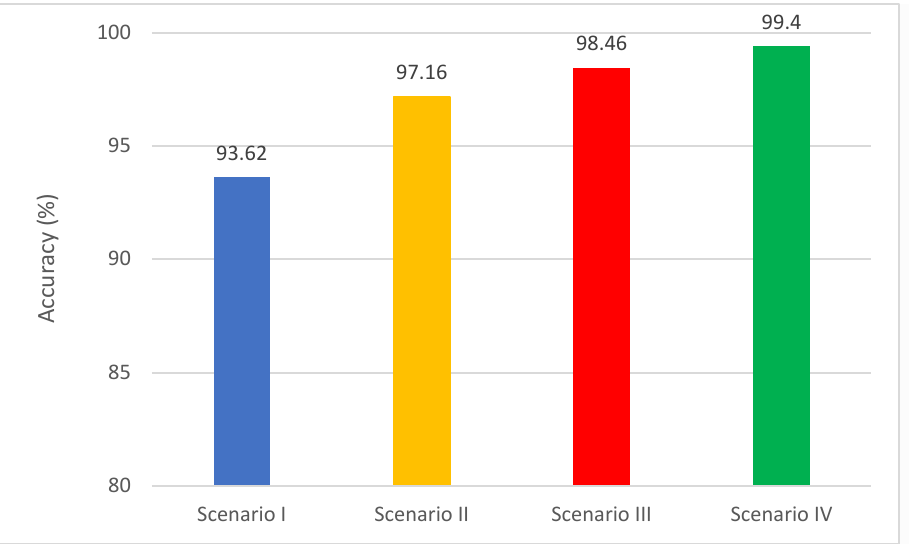
Figure 11. A comparison between the highest classification accuracy achieved for each scenario for multi-class classification level.